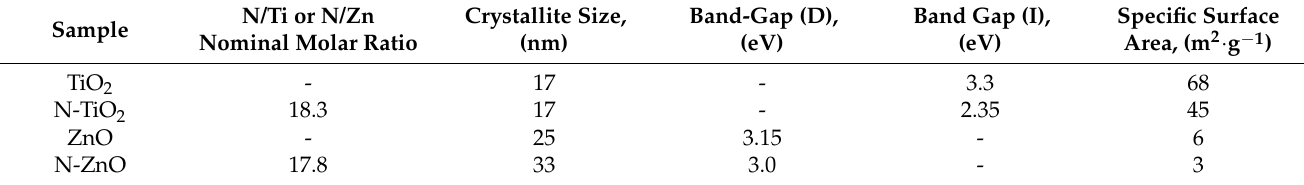
Table 1. Crystallite size, direct (D) and indirect (I) optical band-gap energy, and specific surface area values of the analyzed